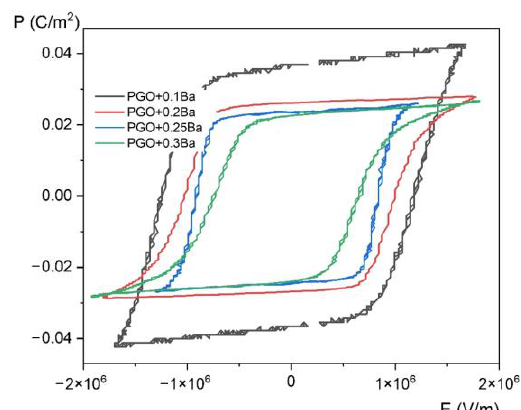
Figure 6. Room temperature P ( E ) (polarization-electric fields) hysteresis loops of PGO + xBa (x = 0.1, 0.2, 0.25, and 0.3).